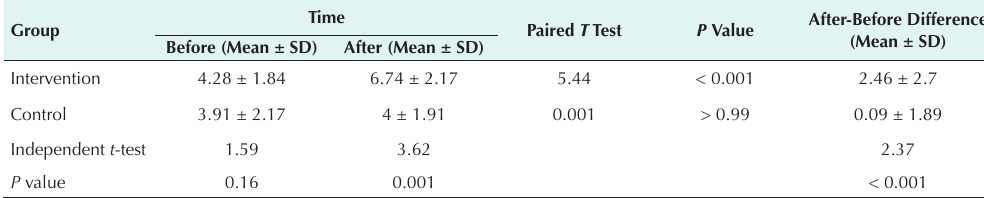
Table 2. Participants’ Medication Adherence Before and After the Study Group